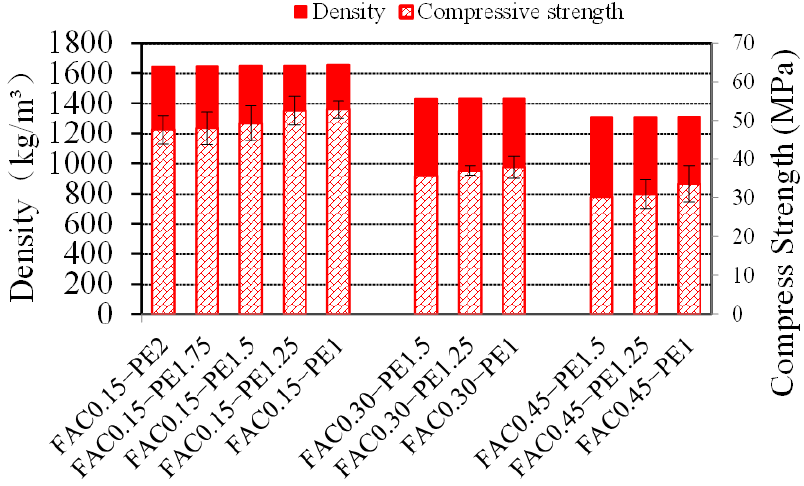
Figure 12. Summary of density and compression of